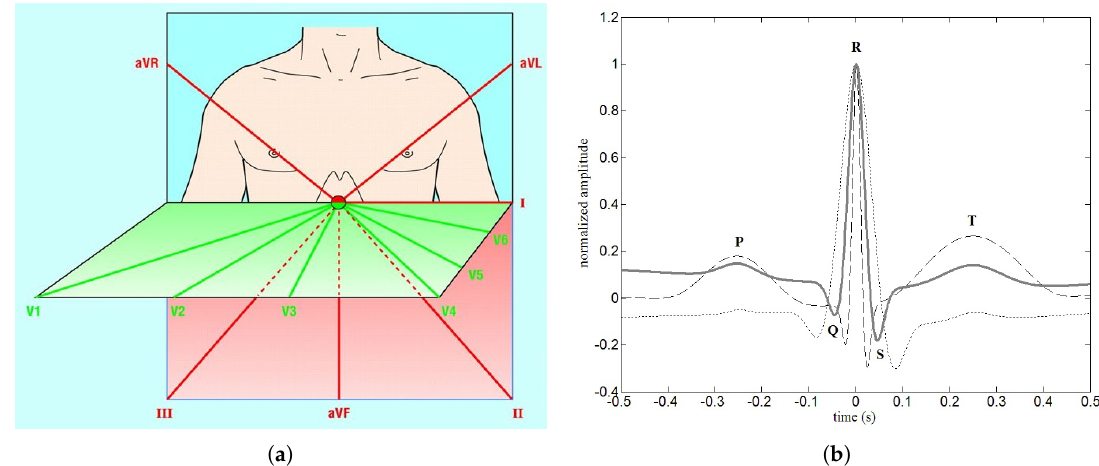
Figure 1. ( a ) Sagittal plane ( x − z plane), frontal plane ( y − z plane) and transverse plane ( x − y plane) (public domain image). ( b ) Typical ECG signals: continuous line represents a normal ECG . Dotted and dashed lines represent pathological ECG